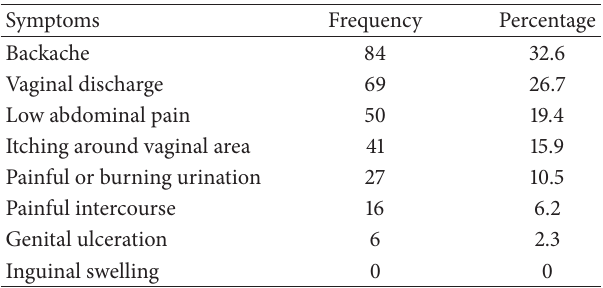
Table 2: Distribution of symptoms suggestive of RTI among married women experienced in last six months ( 𝑛 = 258